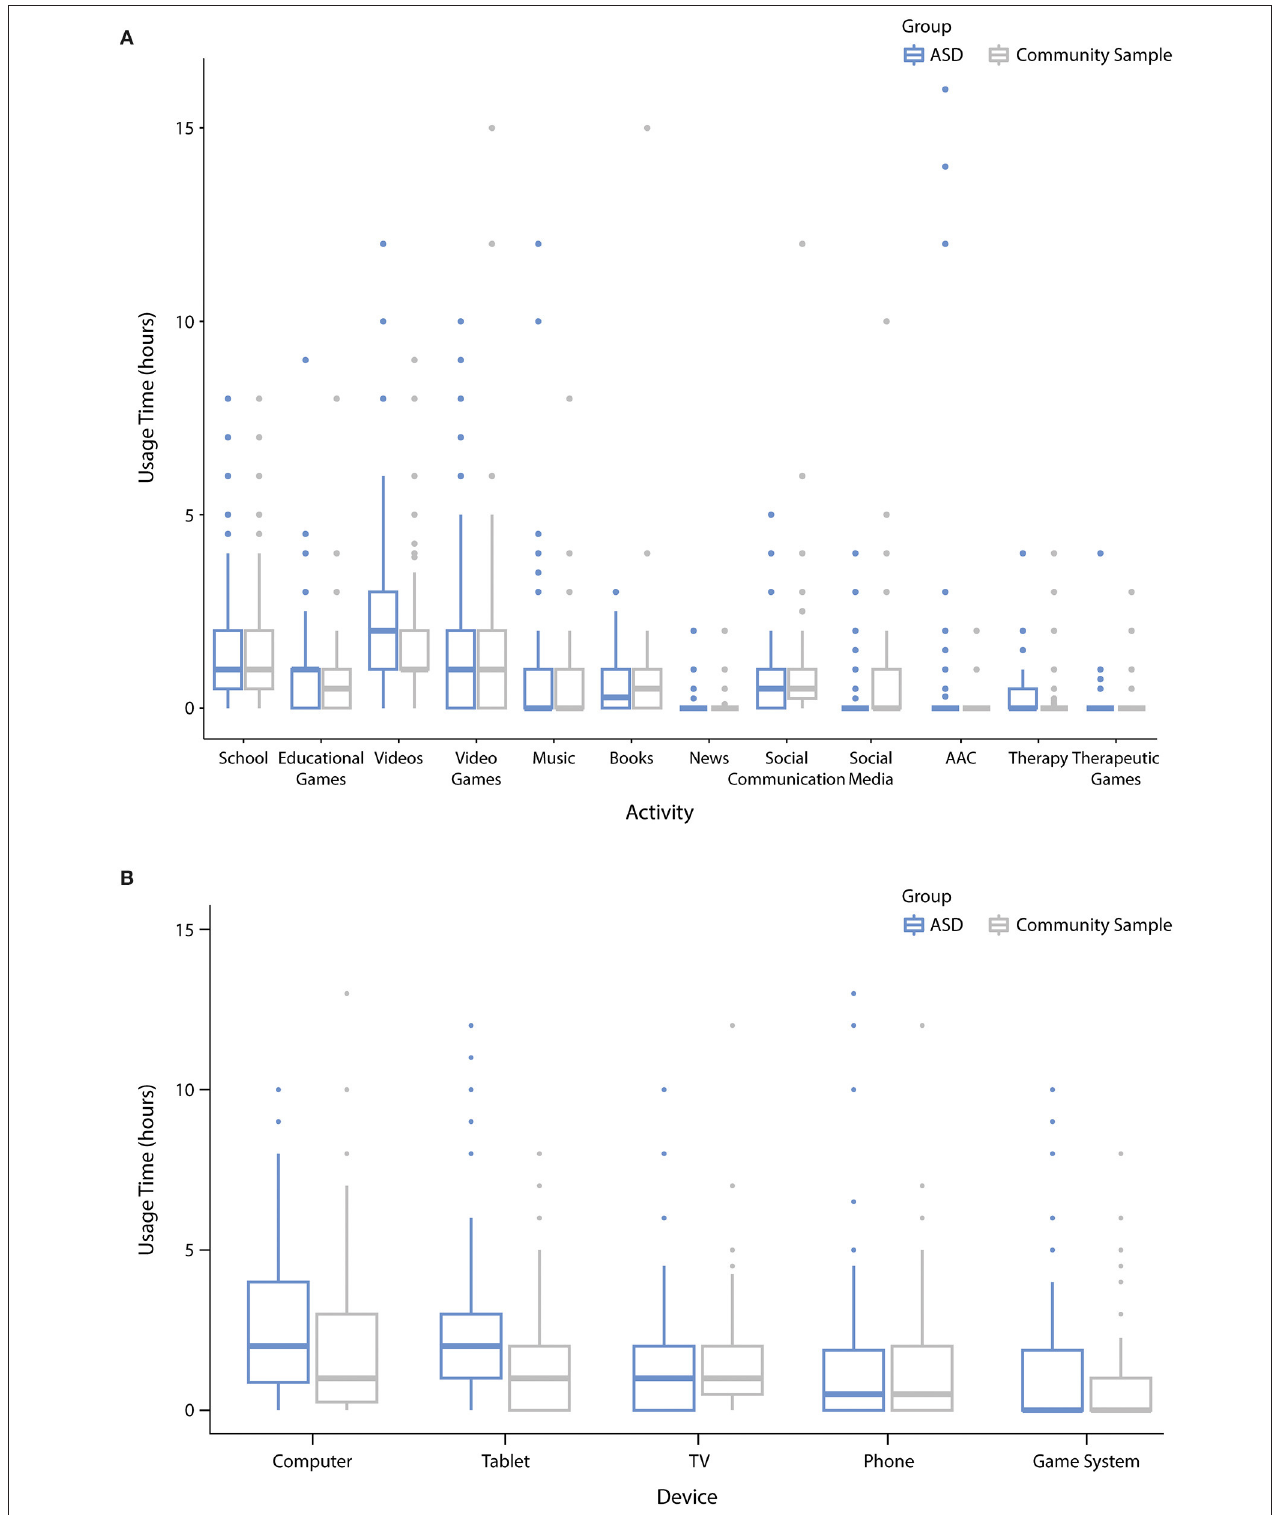
FIGURE 3 | Distribution of screen time during the COVID-19 closures across different (A) activities and (B) devices. Center line represents the median (50% quartile), box limits represent upper (75%) and lower (25%) quartiles, whiskers represent 1.58 × interquartile range (IQR). Outliers are represented as data points beyond the end of the